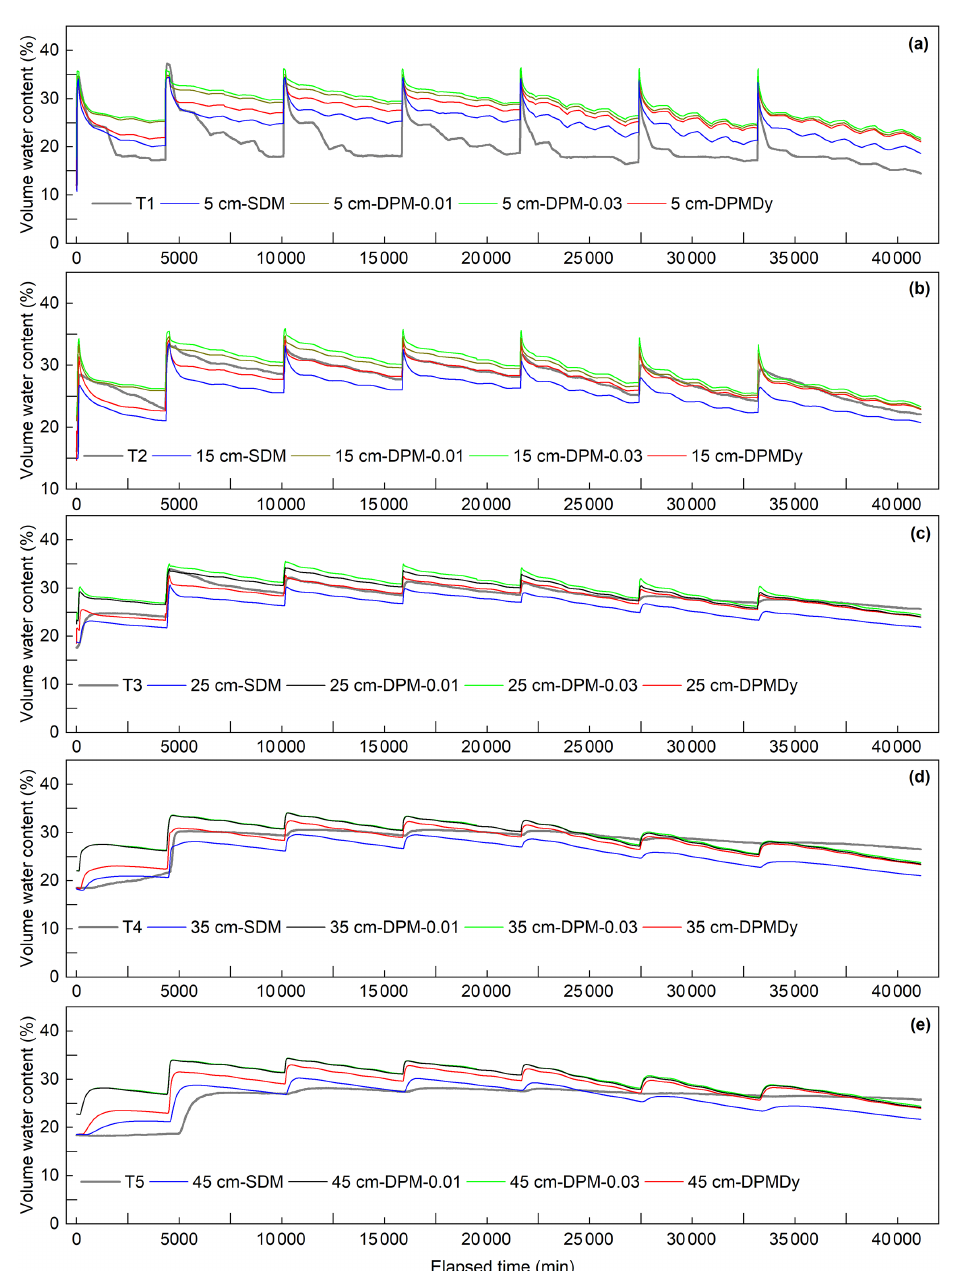
Figure A1. Temporal evolution of the measured and simulated crack ratio and matric suction at different depths. (a) Measured and simulated crack ratio (dynamic DPM) on soil surface and (b–f) measured and simulated matric suction (single-domain model, DPM and dynamic DPM) at depths of 5, 15, 25, 35 and